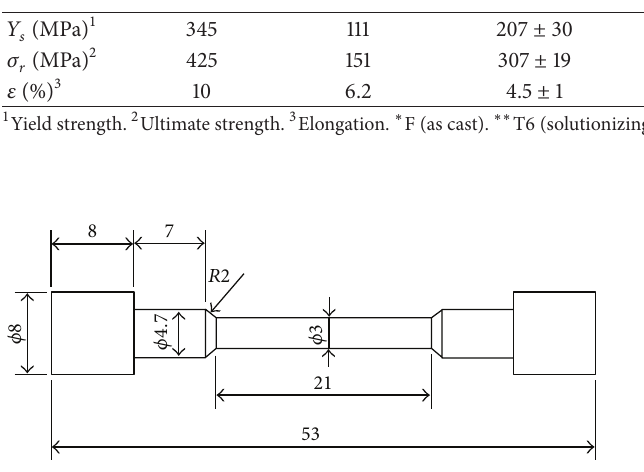
Figure 3: Specimen dimensions for tensile test in mm.